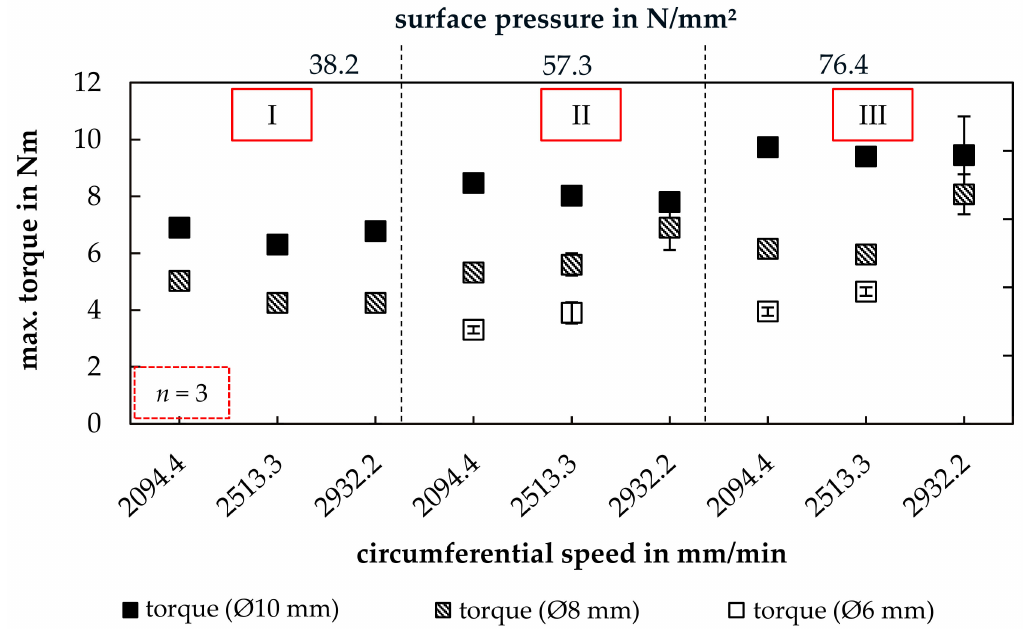
Figure 16. Effects of tool downscaling on the resulting maximum